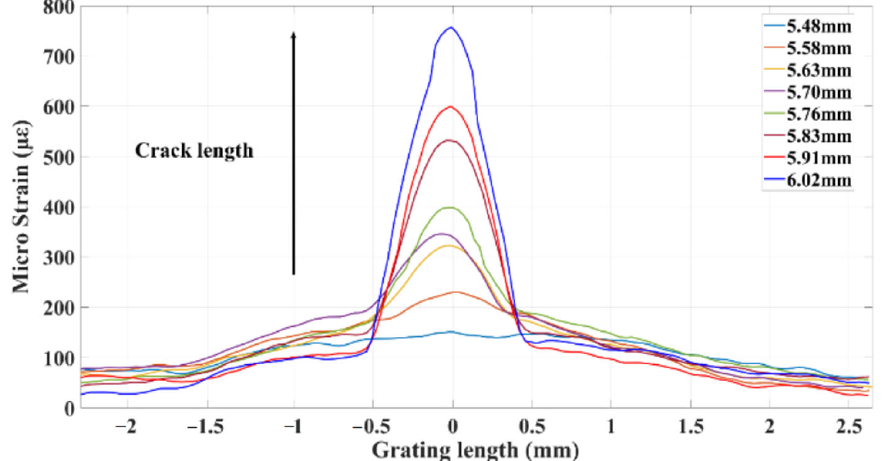
Figure 4. Non-uniform strain distribution at sensor positions of FBG1 obtained by the DIC Figure 4. Non ‐ uniform strain distribution at sensor positions of FBG1 obtained by the DIC method.